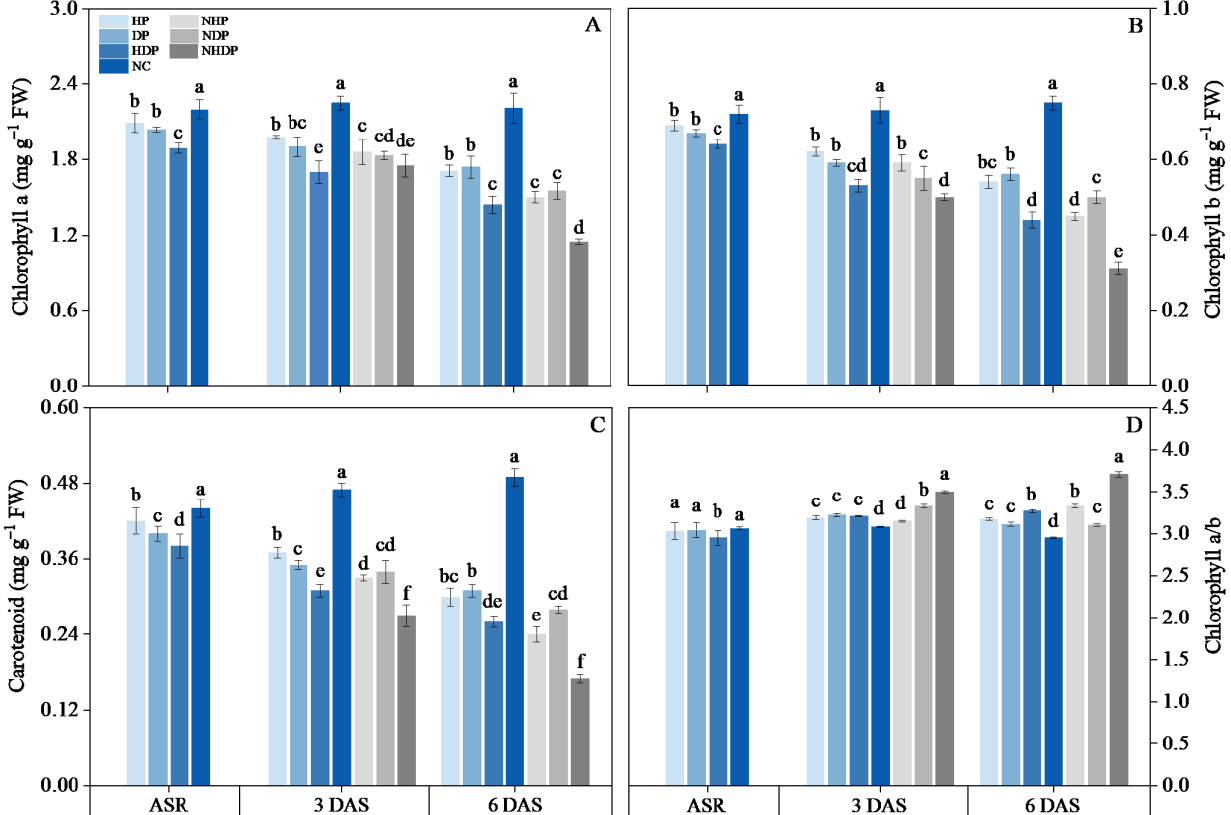
Figure 2. Effects of stress priming on chlorophyll a (Chla, A ), chlorophyll b (Chlb, B ), carotenoid (Car, C ) contents, and chlorophyll a/b (Chla/b, D ) of seedlings under stress conditions. HP, heat priming + later heat stress; DP, drought priming + later drought stress; HDP, combined stress priming + later combined stress; NHP, no heat priming + later heat stress; NDP, no drought priming + later drought stress; NHDP, no combined stress priming + later combined stress; NC, no stress priming + no later stress. The bars represent the means ± SD (n = 5), where different letters designate significant differences at the 0.05 level.